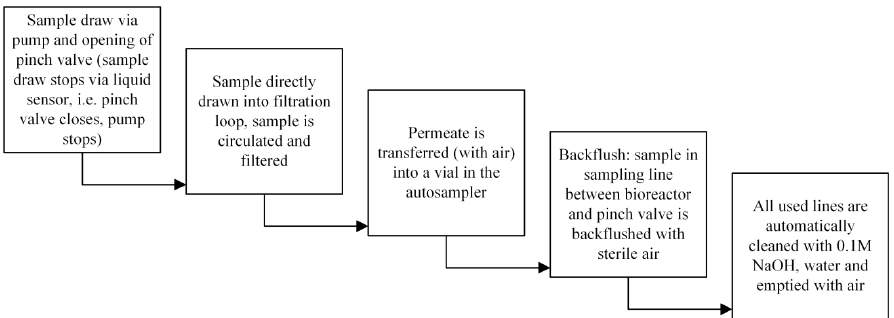
Figure 2. Sampling sequence performed with the system for storage of a cell free sample on the autosampler without dilution. Samples were then transferred via the injection valve on the autosampler to the HPLC or the samples were transferred via a pump on the routing module to the Bio HT.